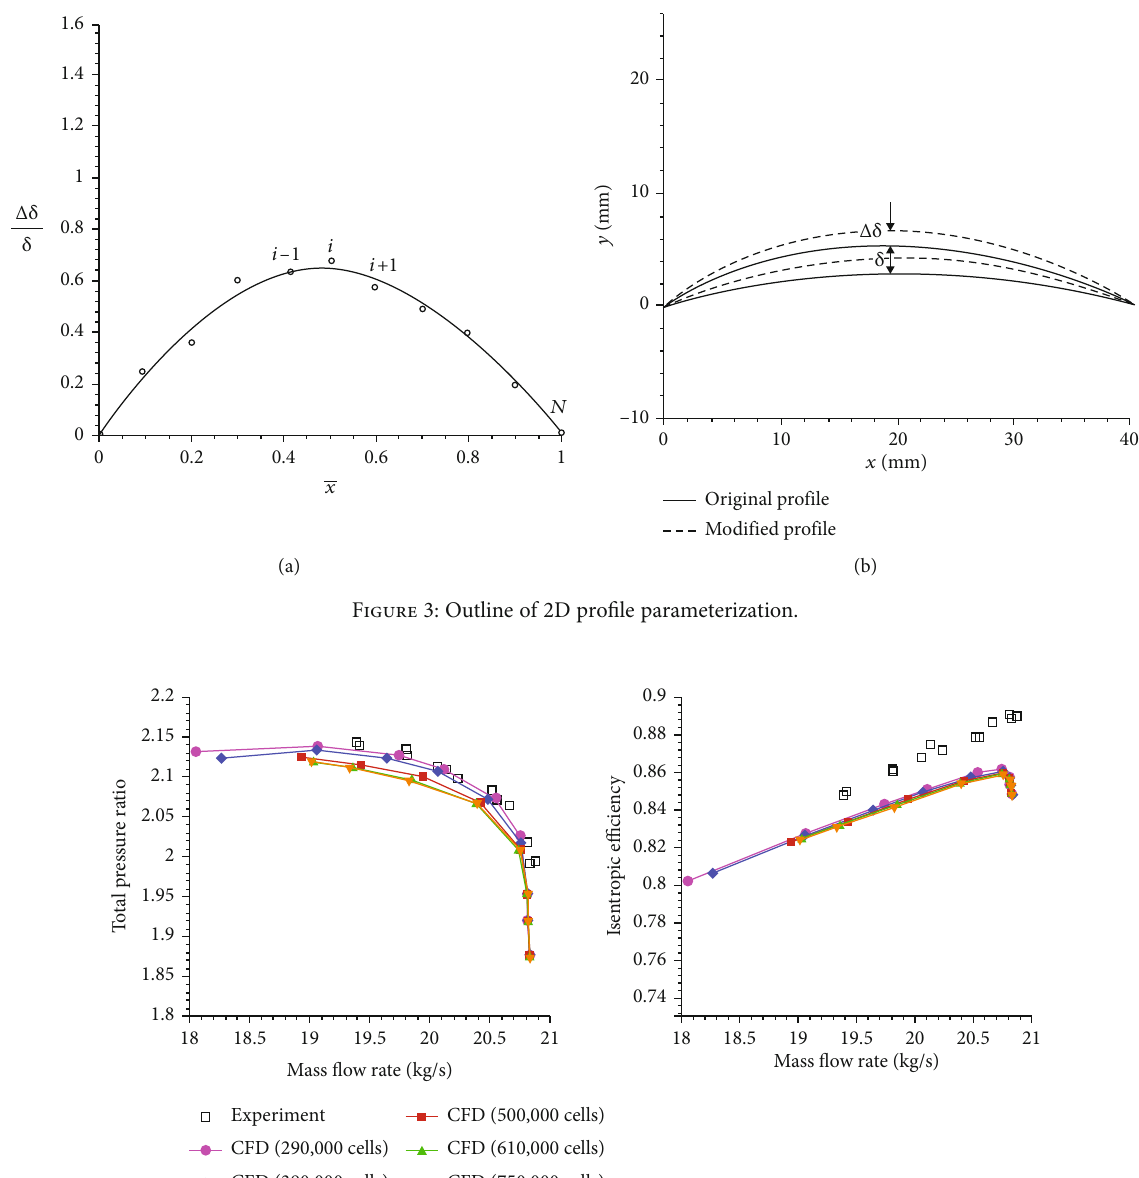
Figure 4: Performance curves of NASA Rotor